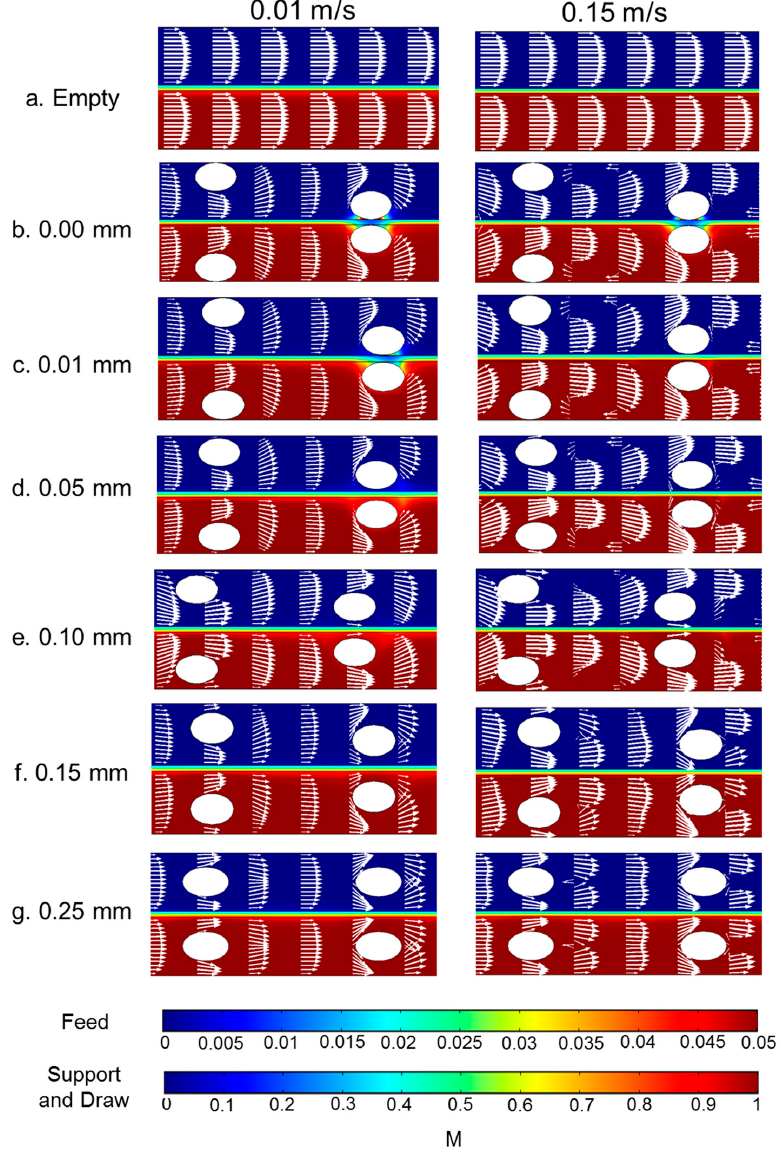
Figure 10. Concentration profile (indicated by the color flood) and velocity profile (indicated by the arrows) under different inlet velocities and membrane–filament distances for spacer-filled flow channels with spacers having center-to-center filaments of 6 mm. The size of the arrows is proportional to the logarithmic value of the velocity to better show the vortices. The data were from the section whose distance from the entrance is approximately 14.5 to 20.5 mm.